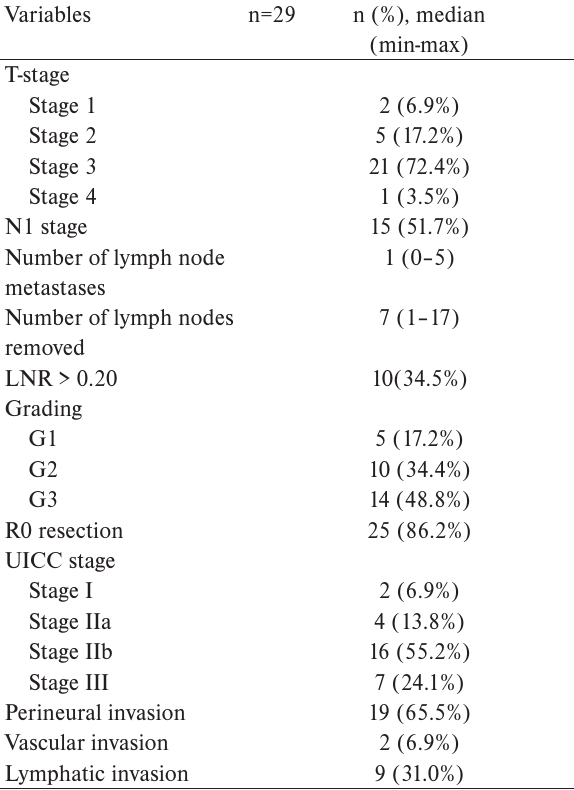
Table 2. Histopathological data for patients with distal adeno- carcinoma and long-term survival.